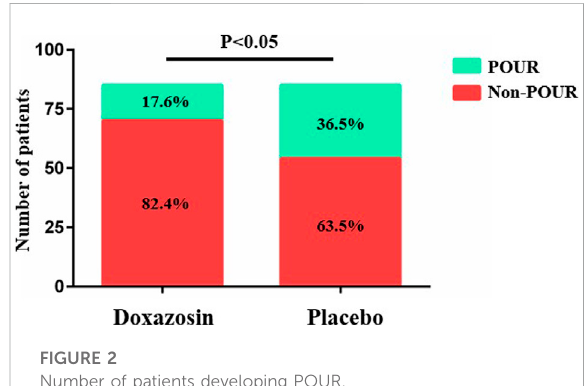
FIGURE 2 Number of patients developing